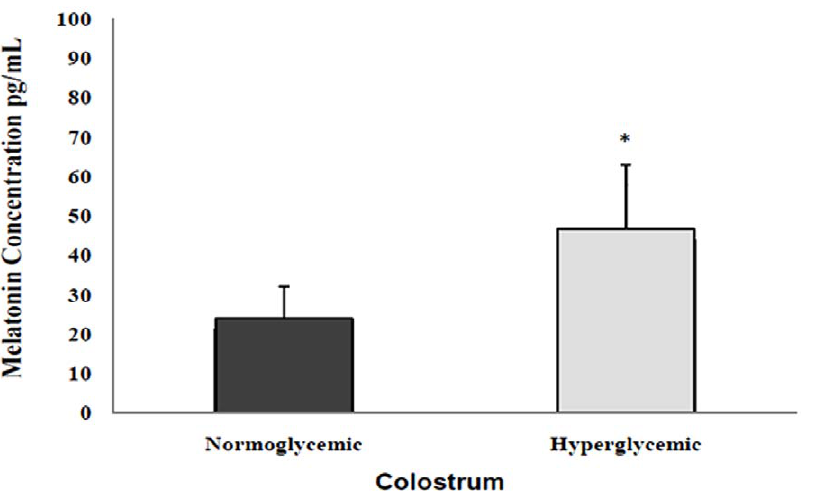
Figure 1. Mean ( ± SD; N=10) melatonin levels (pg/mL) in the supernatant of colostrum from diabetic mothers *indicates difference between normoglycemic and hyperglycemic groups.